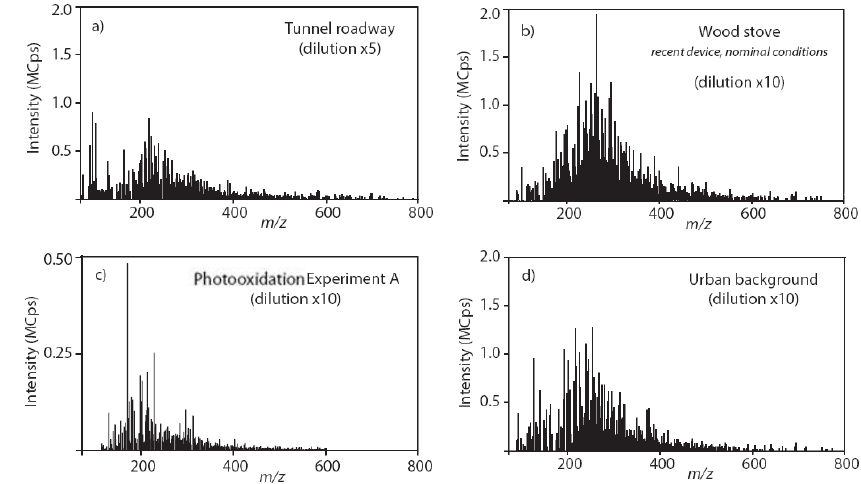
Figure 4. Carboxylic acids mass spectra recorded by NL32 for a) tunnel roadway, b) wood combustion, c) o -xylene photooxidation experiment at high initial concentration levels, and d) urban background samples. As the mass spectra were not recorded during the same sequences, only comparisons based on mass profiles shall be considered, the signal intensities being strongly affected by day-to-day variations.